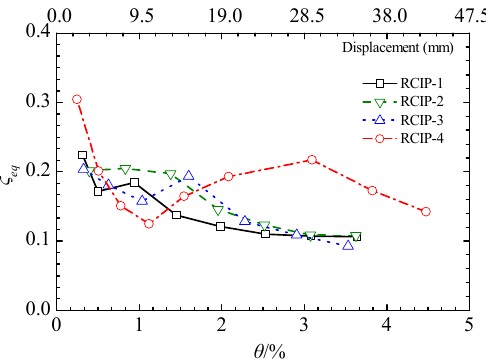
Figure 18. Equivalent viscous damping ratios of the tested specimens.